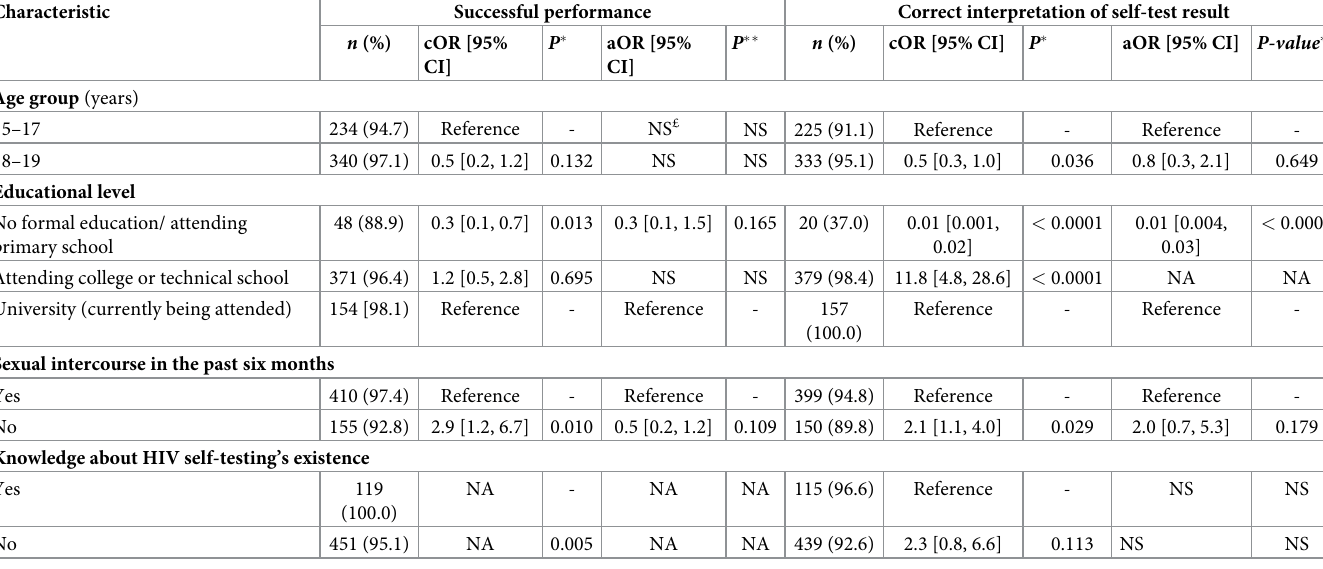
Table 4. Bivariate and multivariate regression analysis of factors associated with the successful performance of Exacto Test HIV Self-test (Biosynex) and the correct interpretation of self-test results among the 597 study participants.